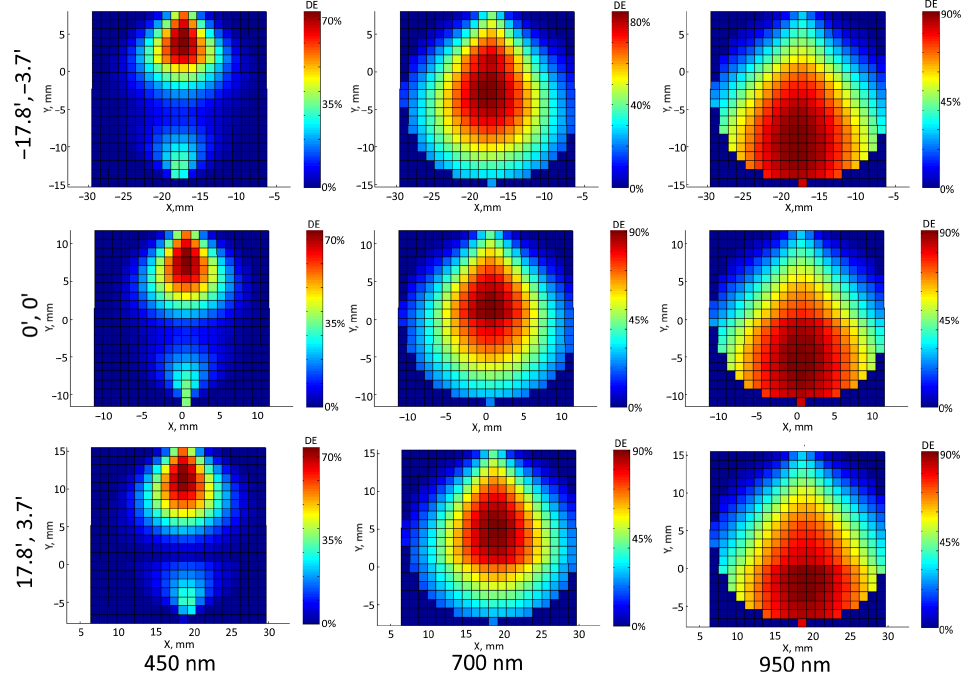
Figure 10. Spatial distribution of the DE across the beam footprint for the simplified composite grism. The spectral dependencies of the average and maximum DE for the simplified com- posite grism are shown on the comparative plot Figure 11 together with the other